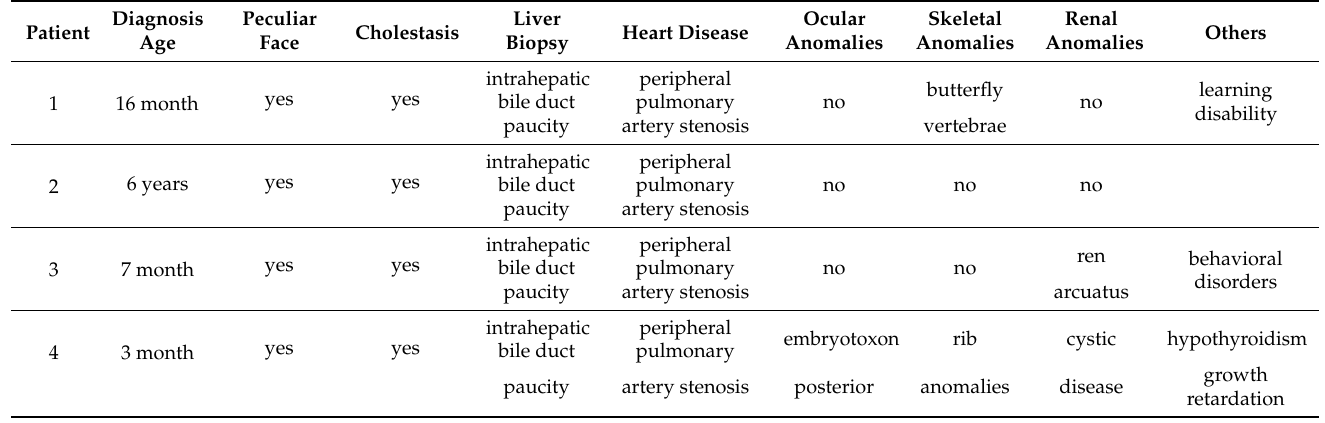
Table 1. Clinical features present in carriers of JAG1 pathogenic variants.